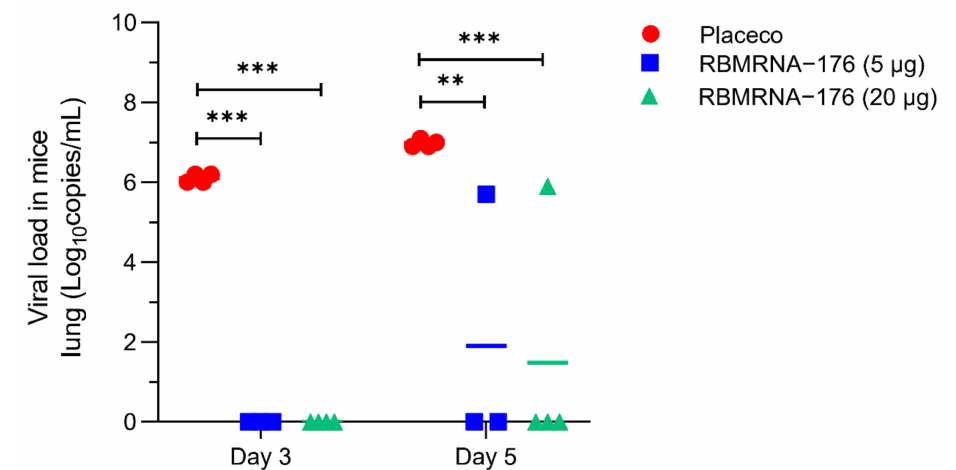
Figure 5. Viral load in lungs of SARS-CoV-2-infected mice vaccinated with RBMRNA-176. K18- hACE2-transgenic mice were vaccinated with 20 µ g RBMRNA-176 following a 21-day prime-boost interval regimen. At week 4, mice were intranasally infected with 5 × 10 4 PFU of SARS-CoV-2. Viral titer ( n = 4) was determined by RT-qPCR detection of viral s gene copies in homogenized supernatants of lung tissues at 3 and 5 dpi. ** p < 0.01, *** p < 0.001, compared with placebo-treated control without RBMRNA-176 vaccination.